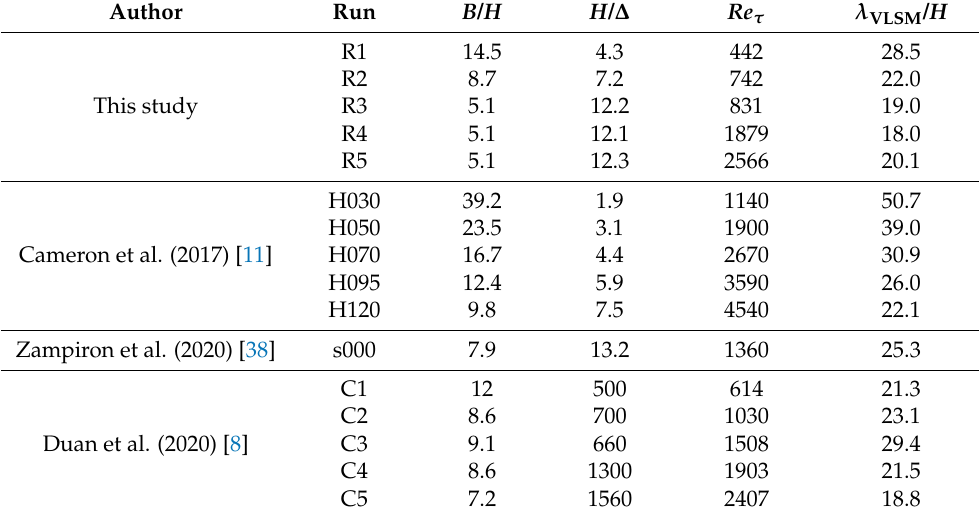
Figure 4. LSM and VLSM wavelengths represented by small and large symbols, respectively. Table 3. Maximal VLSM wavelengths from different sources.